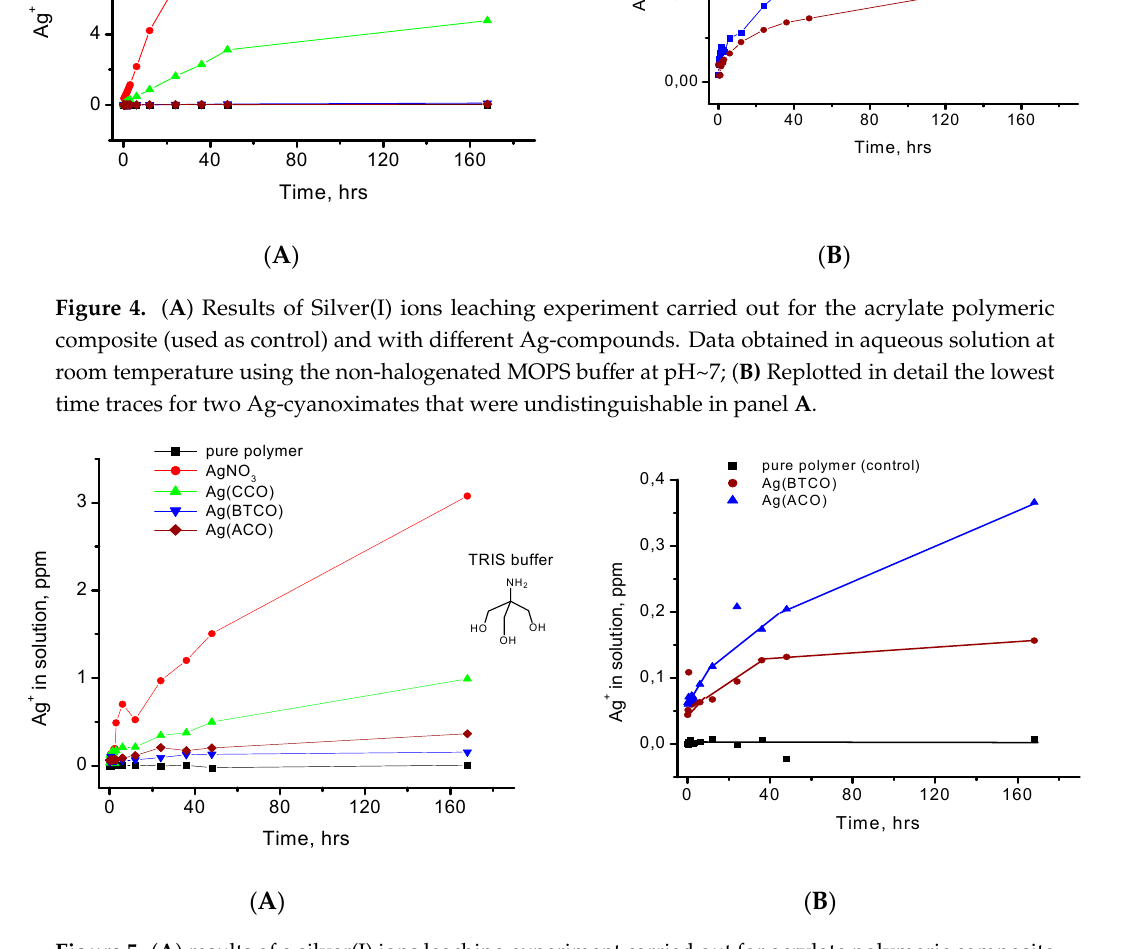
Figure 5. ( A ) results of a silver(I) ions leaching experiment carried out for acrylate polymeric composite (as control) and with different Ag-compounds at room temperature in aqueous media using another non-halogenated TRIS buffer at pH~7; ( B ) replotted in detail data of the lowest three traces from panel A emphasizing low leaching amount of silver ions for two Ag-cyanoximates.